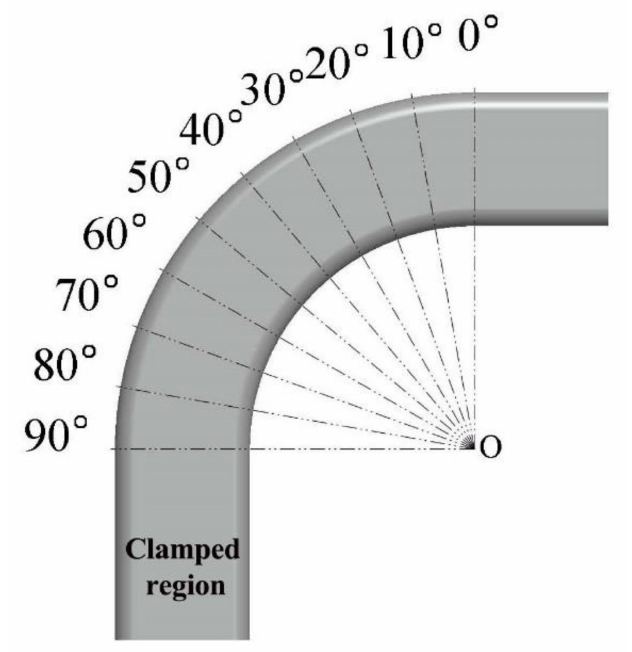
Figure 7. Distribution of the measured sections.